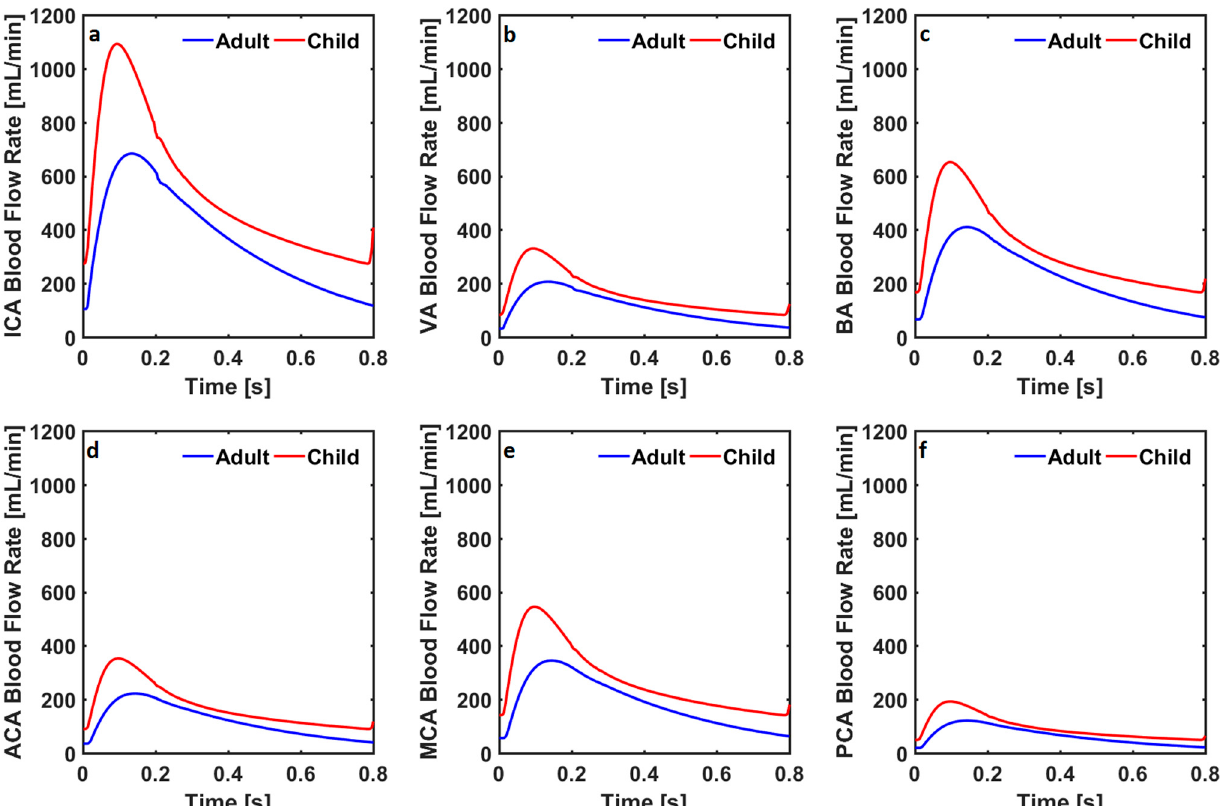
Figure 4. Blood flow rates through ( a ) the internal carotid arteries (ICA), ( b ) the vertebral arteries (VA), ( c ) the basilar artery (BA), ( d ) the anterior cerebral arteries (ACA), ( e ) the middle cerebral arteries (MCA), and ( f ) the posterior cerebral arteries (PCA) in the cardiovascular system models simulating coarctation of the aorta in adults and children.